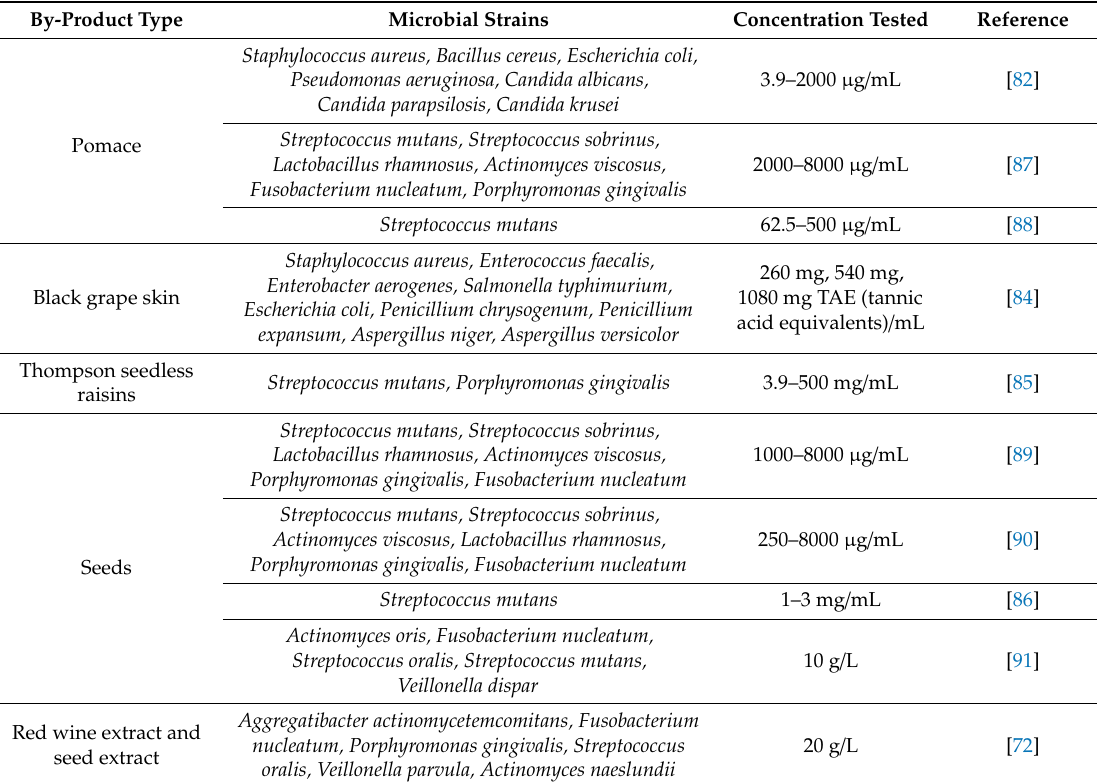
Table 2. Summary of antimicrobial activity of Vitis vinifera extracts against microorganisms involved in dental caries and periodontal